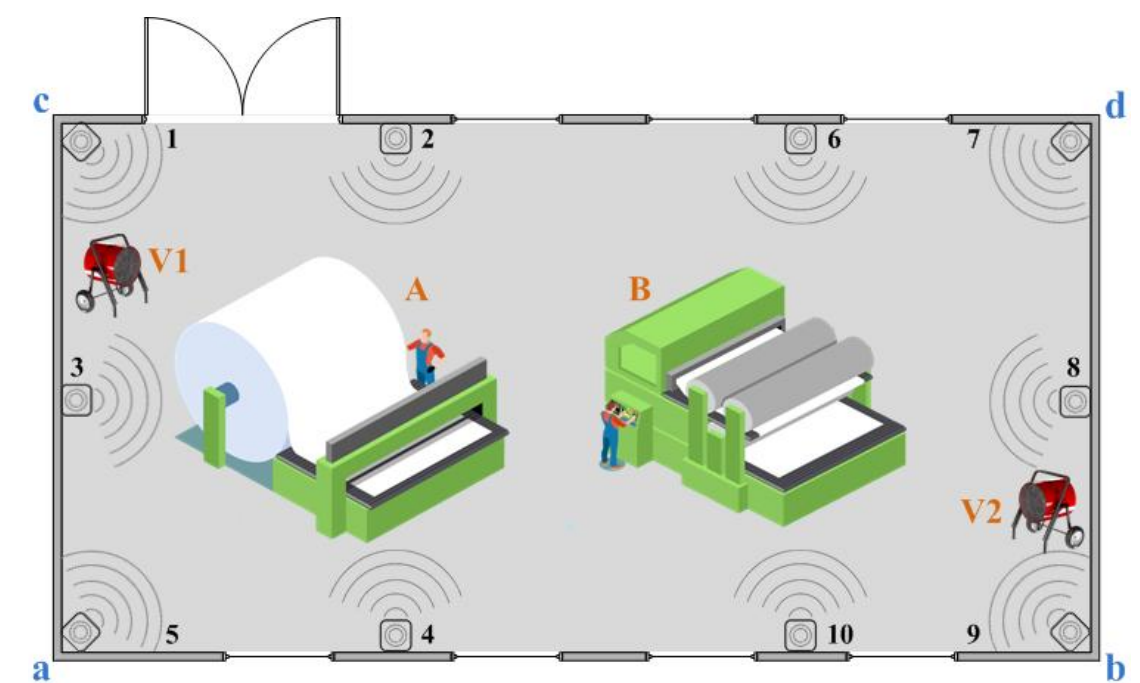
Figure 3. The floor-plan of a paper haberdashery company.